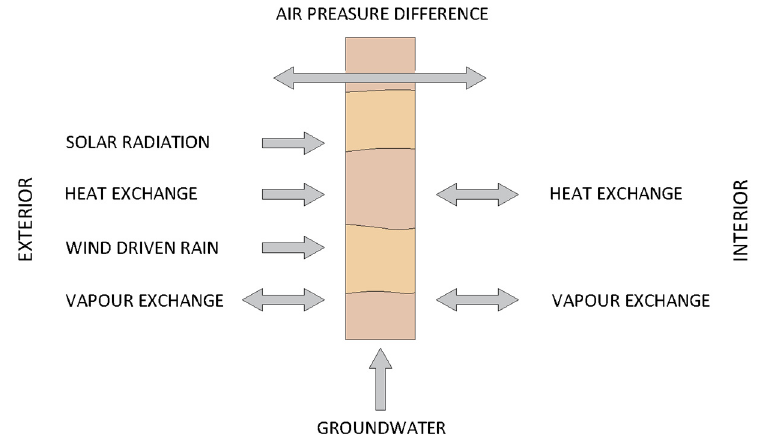
Figure 1. Hydrothermal fluxes and their alternating directions across an earth wall [14].